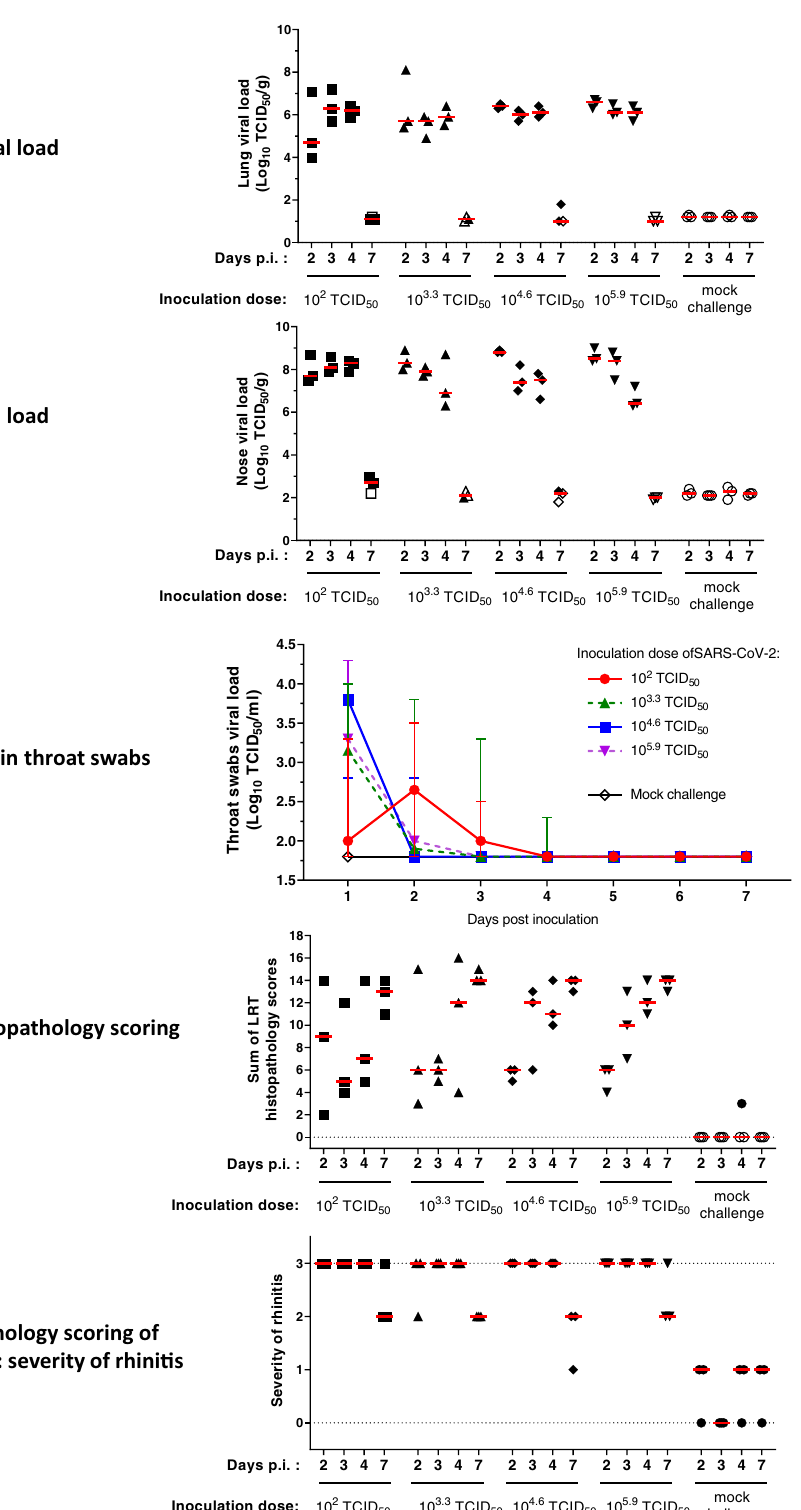
g) and no clear effect of vaccine dose was observed. By contrast, only 3 out of 12 animals immunized with a single dose of Ad26. COV2.S had detectable virus in the lung (median viral load of 10 9 VP and 10 10 VP 10 1.2 TCID 50 /g). Of hamsters vaccinated with a second dose of Ad26.COV2.S, again 3 out of 12 animals